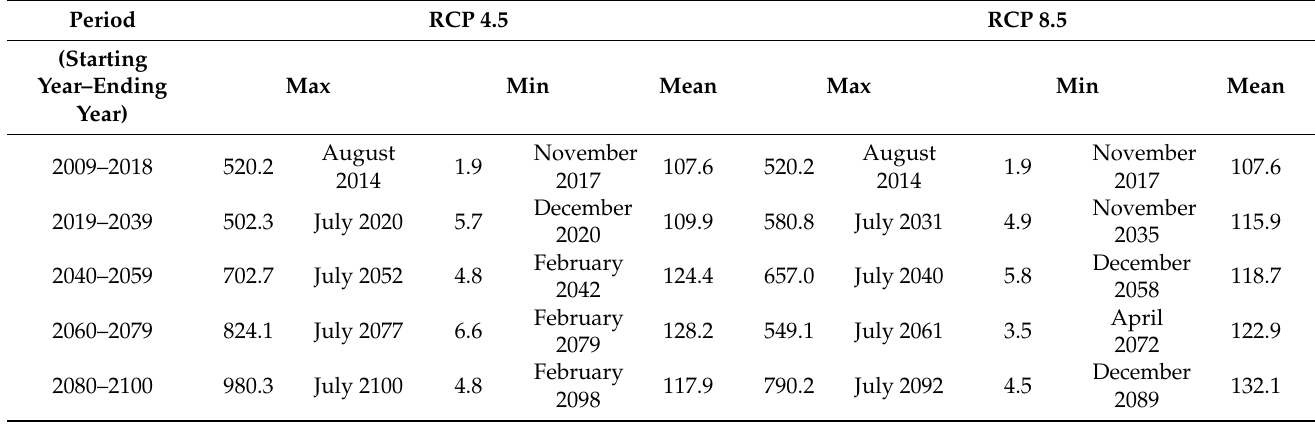
Table 5. Maximum, minimum, and mean precipitation (mm/mon) based on the RCP 4.5 and